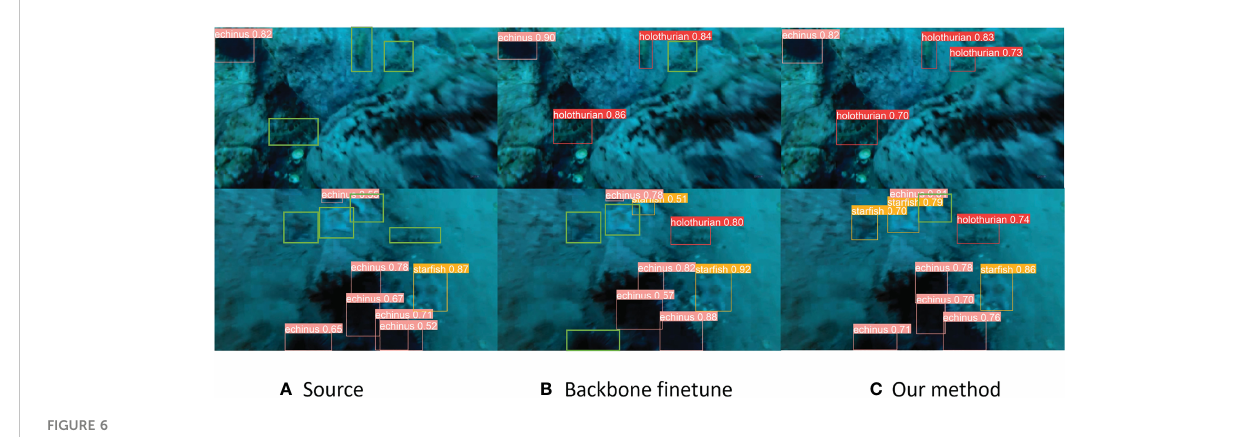
FIGURE 6 Visualization results of ablation experiments.